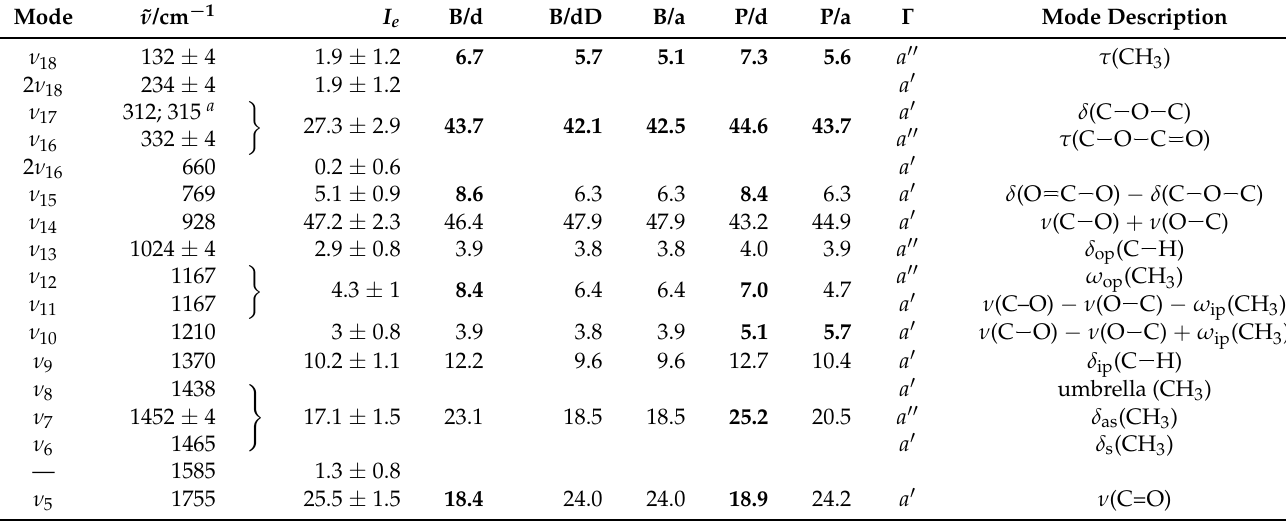
Table 1. Experimental wavenumbers ˜ ν and relative intensities I e (normalised to ν 5 + ν 6 + ν 7 + ν 8 + ν 9 + ν 14 = 100) of methyl methanoate modes ν n ( Γ ) compared to intensities calculated on different levels in the double-harmonic approximation: B = B3LYP, P = PBE0, d = def2-QZVPP, dD = def2-QZVPPD, a = aug-cc-pVQZ, in bold, if the harmonic value disagrees with (anharmonic) experiment in its error bars by more than 20%. For vibrations without a sharp Q -branch, the average of the wavenumbers of the rotational maxima is given. Description of vibrations: ν stretching, δ bending, τ torsion, ω wagging, ip/op in plane/out of plane, (a)s (a)symmetric. a An asymmetric double peak is